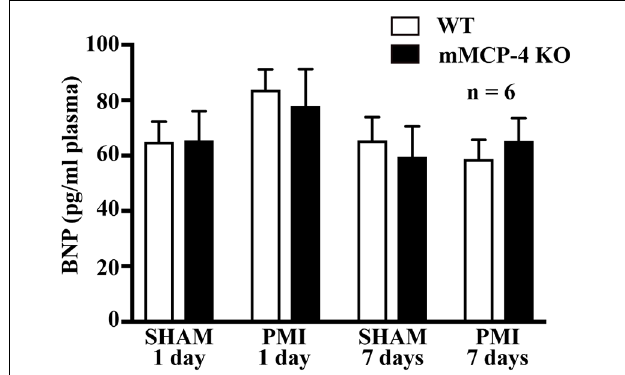
FIGURE 5 | Plasma levels of BNP 1 or 7 days after SHAM or PMI surgery as measured by ELISA. n = 6 (one-way ANOVA P > 0.05).